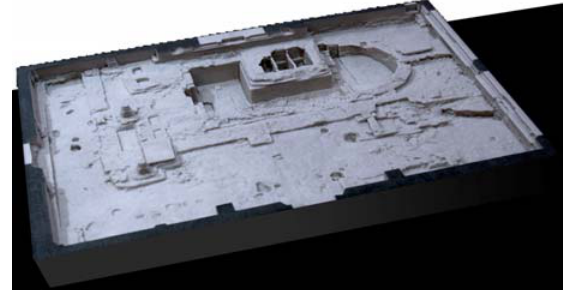
Figure 9. Solid model of Santa Maria del Lavello (Lecco, Italy)